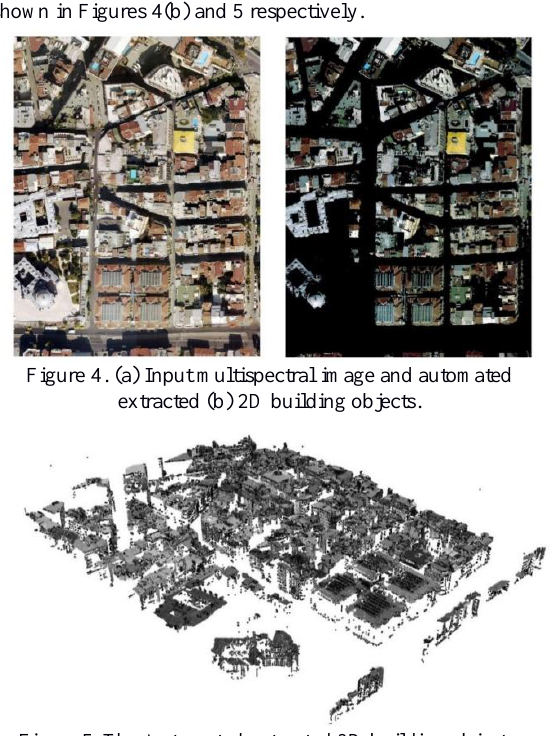
Figure 5. The Automated extracted 3D building objects.